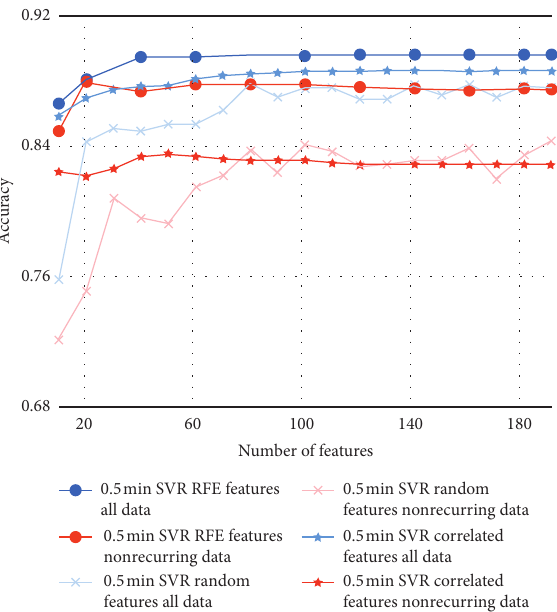
Figure 13: Performance comparison of RFE, correlation-based, and random-selection approaches for selecting important attributes; results correspond to an SVR model for the 30sec aggregation level. RFE provides the highest